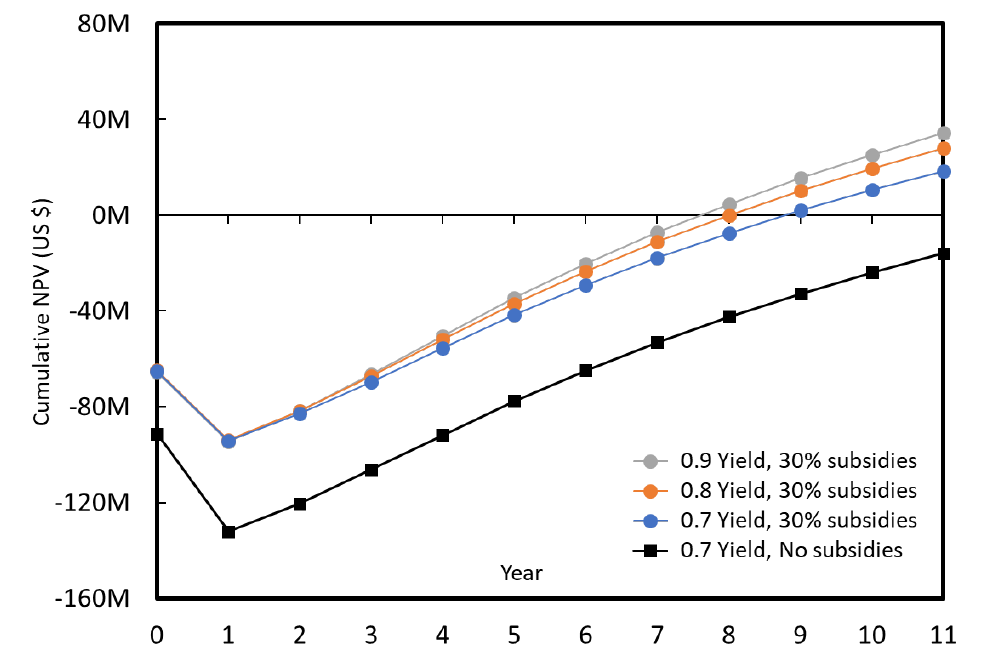
Figure 16. Cumulated NPV over 10 years of production, for a 50,000 tons/year plant, with and without 30% subsidies.